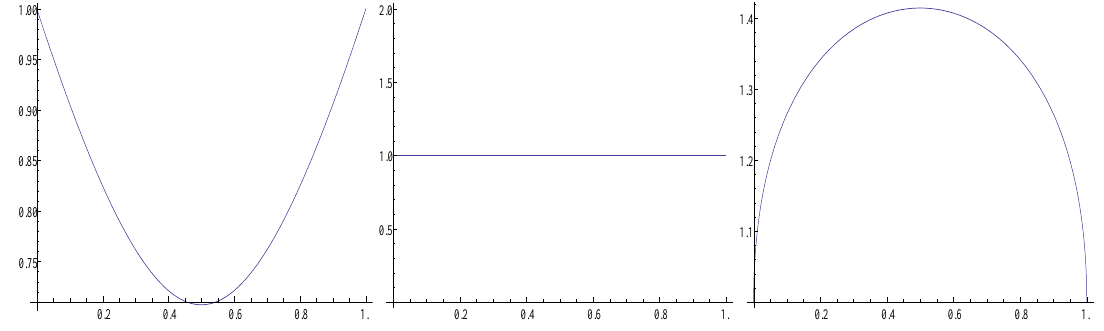
Figure 1. p -variation of the points ( t ,1 − t ) for: ( left ) p = 2; ( middle ) p = 1; and ( right ) p =